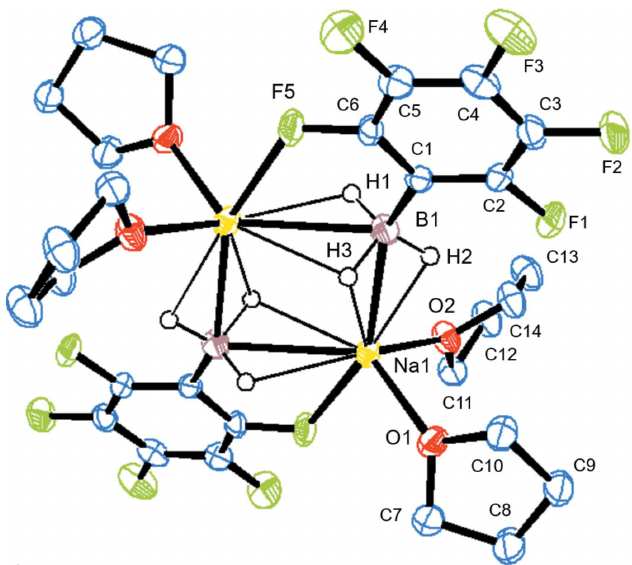
Figure 1 The molecular structure of the title compound, with atom labels and 50% probability displacement ellipsoids for non-H atoms. H atoms other than hydrides have been omitted for